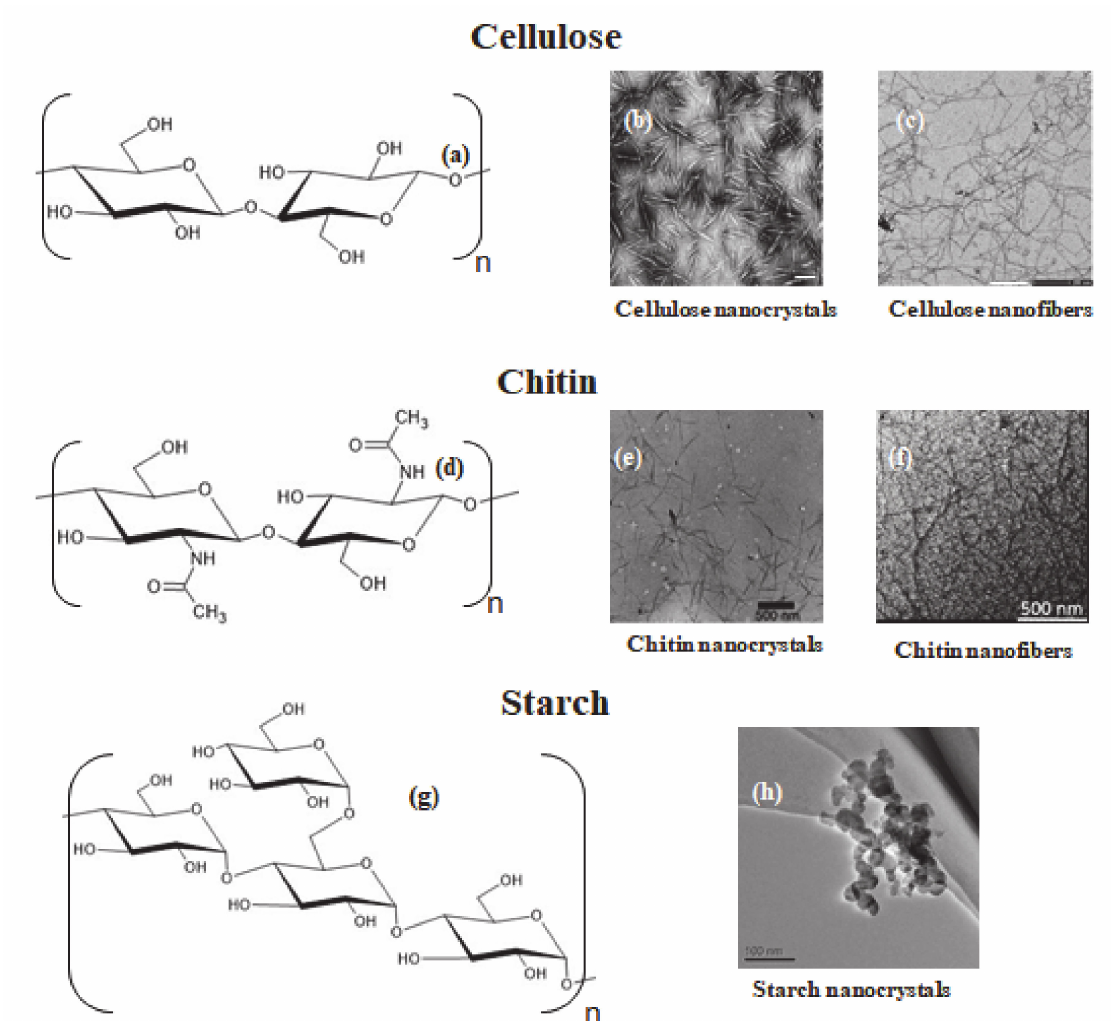
Figure 1. Repeating unit structures for cellulose, chitin, and starch, and TEM micrographs of their correspondingnanoparticles. ( a )Repeatingunitofcellulose. ( b